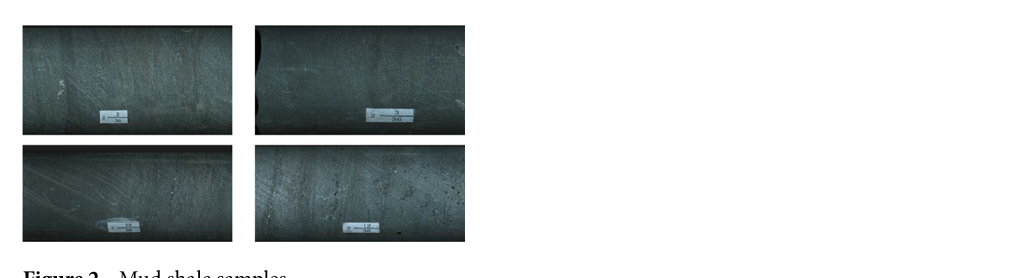
Figure 2. Mud shale